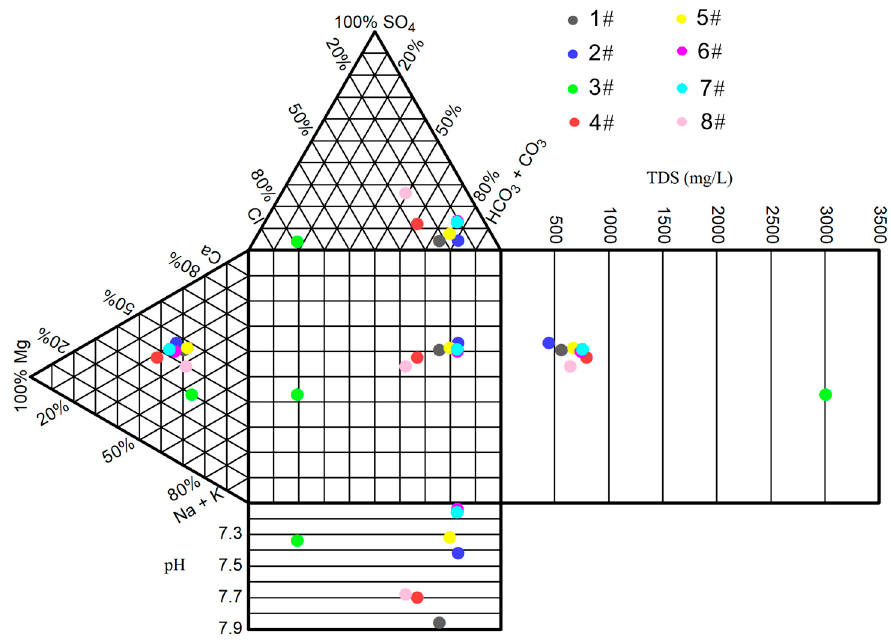
Figure 3. Durov plots of water samples from sampling sites in the study area.